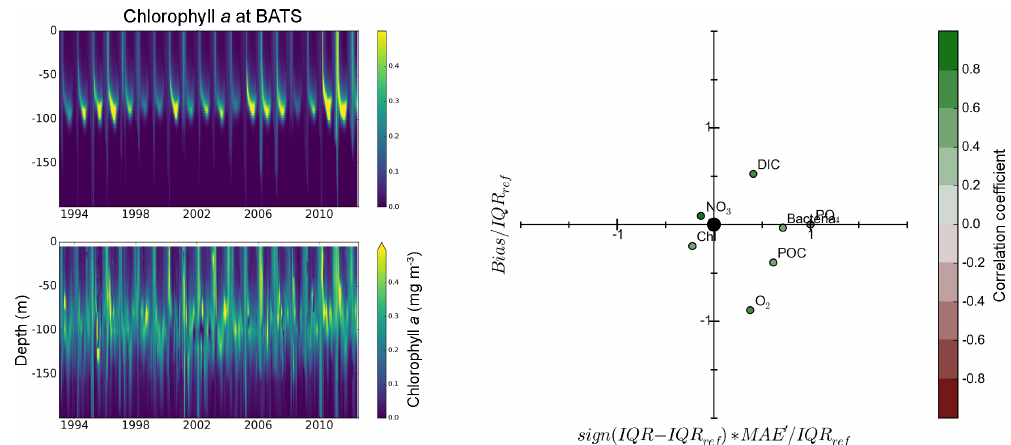
Figure 9. Simulation results vs. in situ data at BATS – left panels: chlorophyll a concentrations (top panel – model, bottom panel – inter- polated HPLC data); right panel: target diagram with bias (abscissa), MAE’ (ordinate), and Spearman correlation (colour code) for oxidized nitrogen (NO 3 ), phosphate (PO 4 ), silicate (Sil), dissolved inorganic carbon (DIC), dissolved oxygen (O 2 ), chlorophyll a (Chl), and particulate organic carbon (POC).